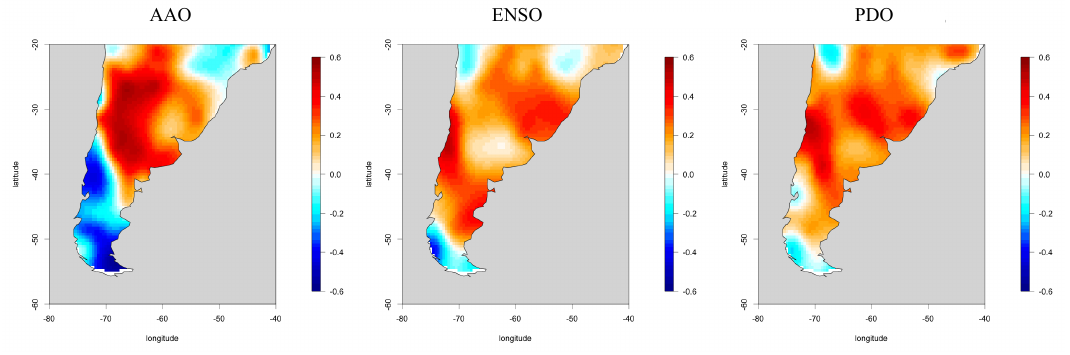
Fig. 14. Correlations (1950-1993) of reconstructed summer PDSI with the main ocean-atmosphere indices: AAO, ENSO, and PDO.